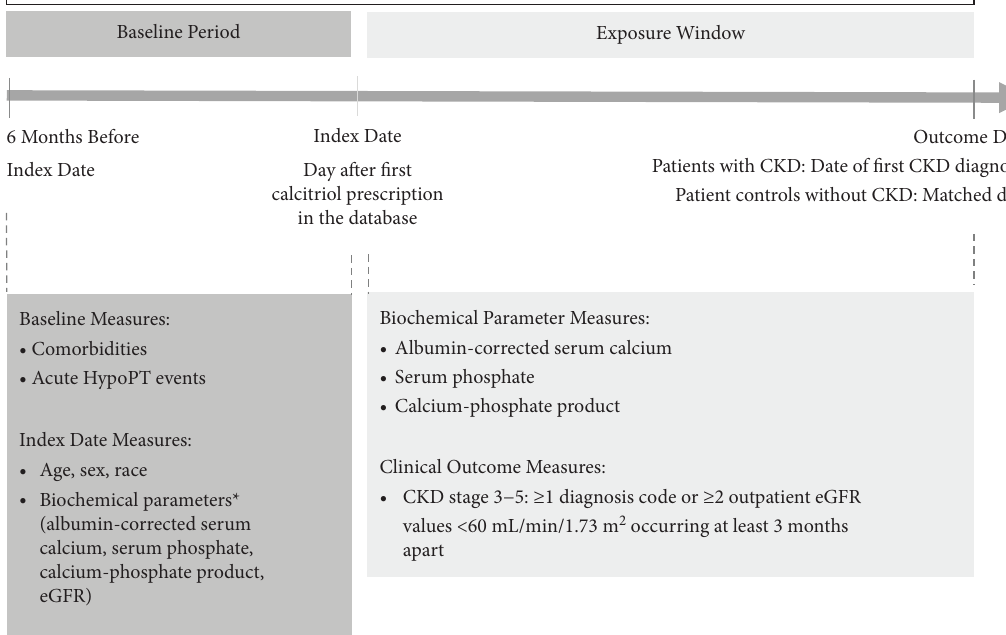
Figure 1: Study Design. CKD: chronic kidney disease; eGFR: estimated glomerular fltration rate; HypoPT: hypoparathyroidism. ∗ Value closest to the index